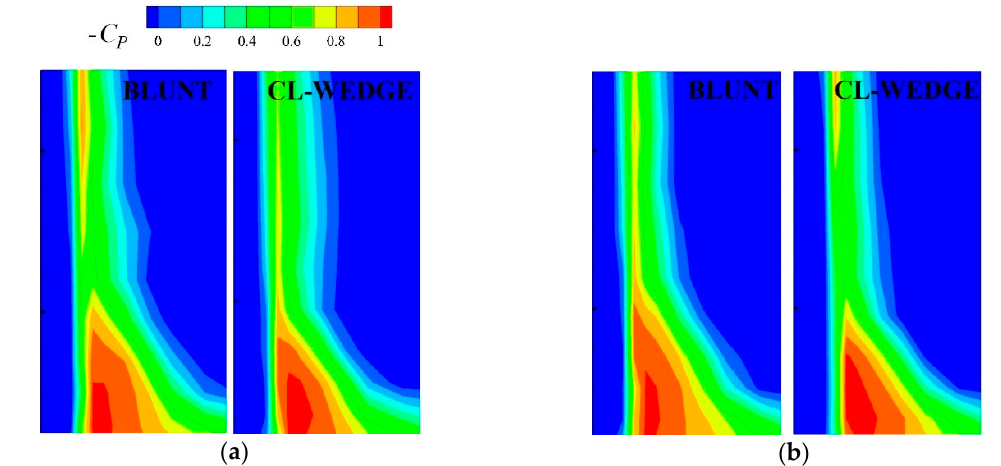
Figure 23. The Cp contour at 1.1 chord length exit of BLUNT and CL-WEDGE: ( a ) at Ret = 2500 ; ( b ) at Re t = 3500.